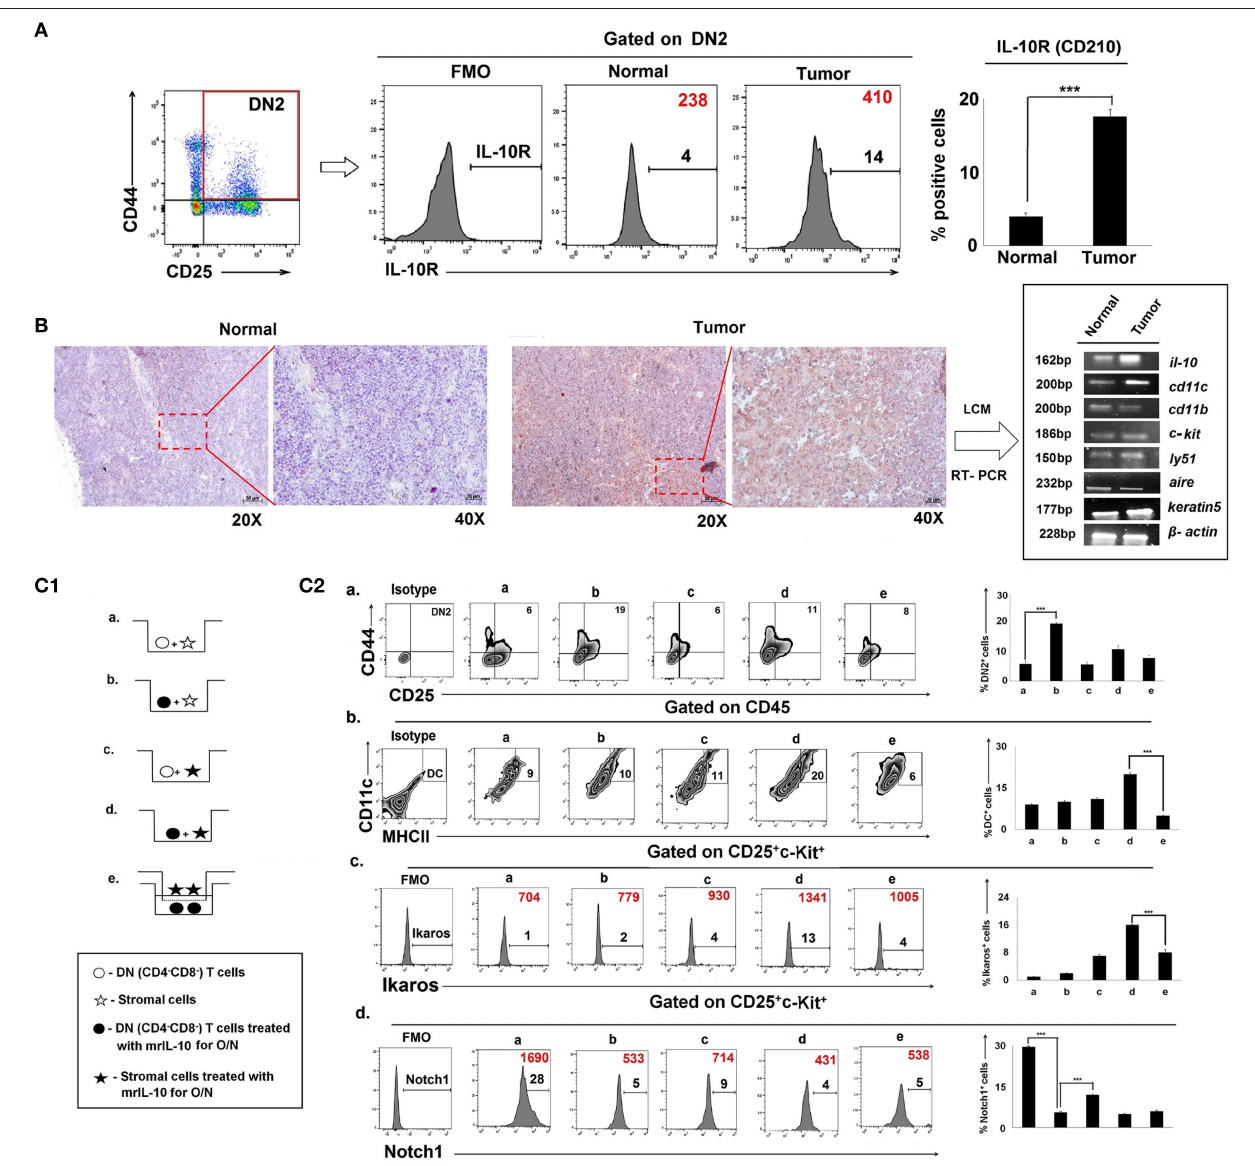
FIGURE 7 | Physical interaction between IL-10R high T cells and stromal cells is required in tumor-induced early arrest and switching of DN2 pro-T cells toward DCs: (A) IL-10 receptors in thymic DN2T cells are represented by flow-cytometric histograms (positive percentages are written in black, and MFI values are written in red). Bar diagram represents mean of positive percentages ± SE; n = 3, *** p < 0.001. (B) IL-10-rich zone in thymi of normal and tumor hosts was identified immunohistochemically. IL-10-rich regions, i.e., cortico-medullary region of thymus, are shown in 20 × and 40 × magnification, and these zones were isolated using a laser capture microscope to analyze the gene expression using mRNA by RT-PCR, keeping β -actin as a loading control. Genes include il-10 , cd11c , cd11b , c-kit , ly51 , aire , and keratin5 in samples from normal and tumor cohorts ( n = 3 in each case). (C1) Pictorial diagram of experimental set up of T-cell and stromal-cell interaction. DN T cells were isolated by BD Imag, and stromal cells were isolated by 2-deoxyguanosine treatment in FTOC culture for 3 days. DN-T cells and stromal cells were then co-cultured in transwell with or without trans-membrane and IL-10 treatment. Different conditions are: (a) DN T cells were co-cultured with stromal cells, (b) DN T cells were pre-treated with mrIL-10 overnight and co-cultured with stromal cells, (c) stromal cells were pre-treated with mrIL-10 overnight and co-cultured with DN T cells, (d) stromal cells and DN T cells were pre-treated with mrIL-10 overnight and then co-cultured, (e) stromal cells and DN T cells pre-treated with mrIL-10 overnight, and then DN T cells co-cultured with stromal cells were separated with 0.8- µ m trans-membrane in trans-well. (C2) Flow cytometric representations of thymic cells for (a) CD25 + CD44 + , (b) CD45 + CD11c + MHCII + , (c) CD25 + c-Kit + Ikaros + (d) CD25 + c-Kit + Notch1 + from (a–e) culture conditions as mentioned. In histograms, MFI values are represented in red, and positive percentages of cells are presented in black. Bar diagrams in each figure show the mean ± SE of 3 individual observations; *** p < 0.001.